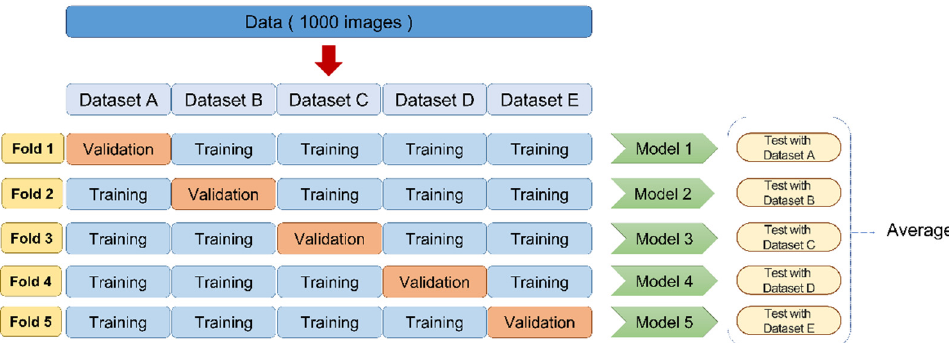
Figure 2. Five-fold cross-validation. The data were randomly divided into 5 groups, each consisting of 200 images. Four of these groups were used as training data and the remaining group was used as validation data. The diagnostic performance for each cross-validation set was evaluated, and the average of the five models was regarded as the estimated performance.